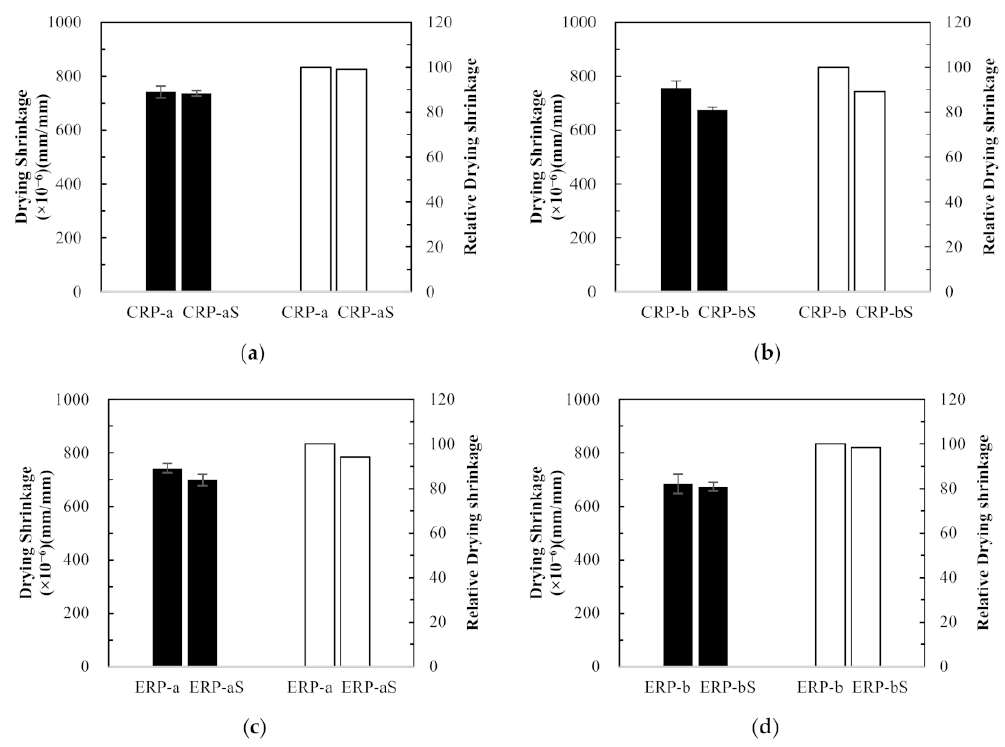
Figure 10. Concrete drying shrinkage results and relative values with and without recycled concrete aggregate coating treatment: ( a ) CRP-a versus CRP-aS, ( b ) CRP-b versus CRP-bS, ( c ) ERP-a versus ERP-aS, and ( d ) ERP-b versus